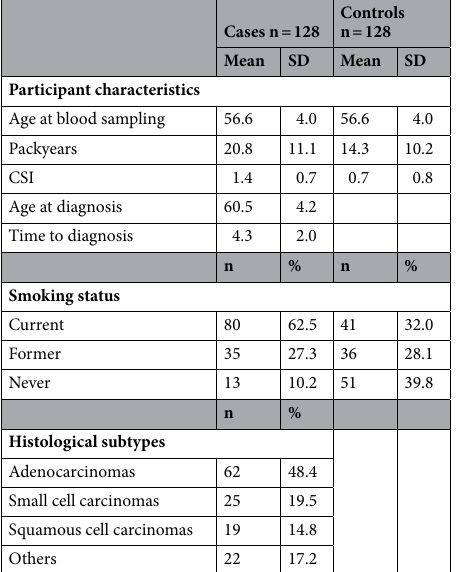
Variable\years to